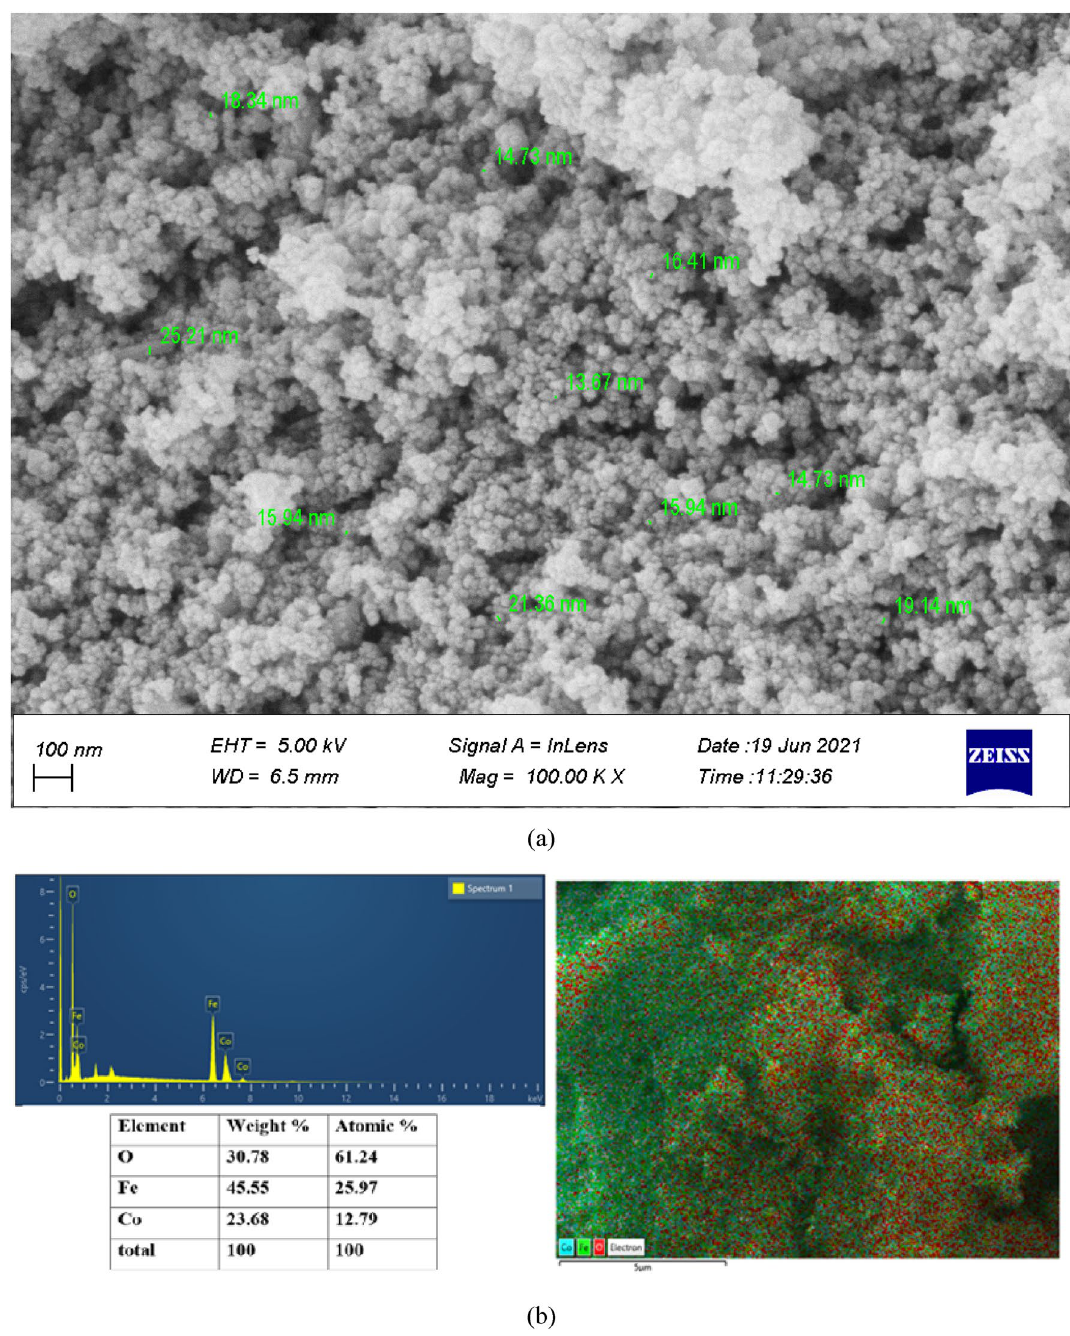
Figure 1. The results of ( a ) FESEM analysis; ( b ) EDS analysis, for CoFe 2 O 4